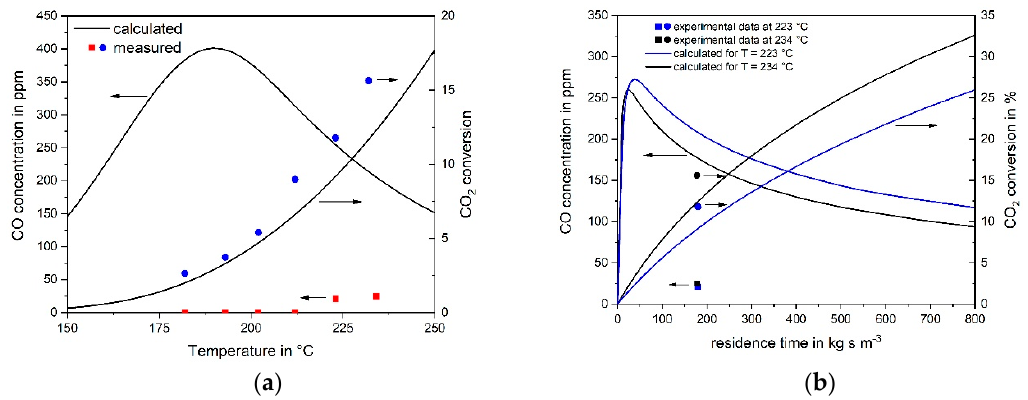
Figure 5. Calculated and measured CO concentration during CO 2 methanation (feed gas: 6 vol% CO 2 , 55% H 2 , rest N 2 , m cat = 2 g). ( a ) reaction temperature variation for V STP = 22 l h − 1 ; ( b ) residence time variation at 223°C or 234°C. Calculation based on (wrong) assumption that CO 2 is only converted to CO via reverse water gas shift (RWGS) and then subsequently to methane (indirect mechanism). The large deviation of the calculated CO content from the measurement strongly indicates that CO 2 is directly converted to methane.